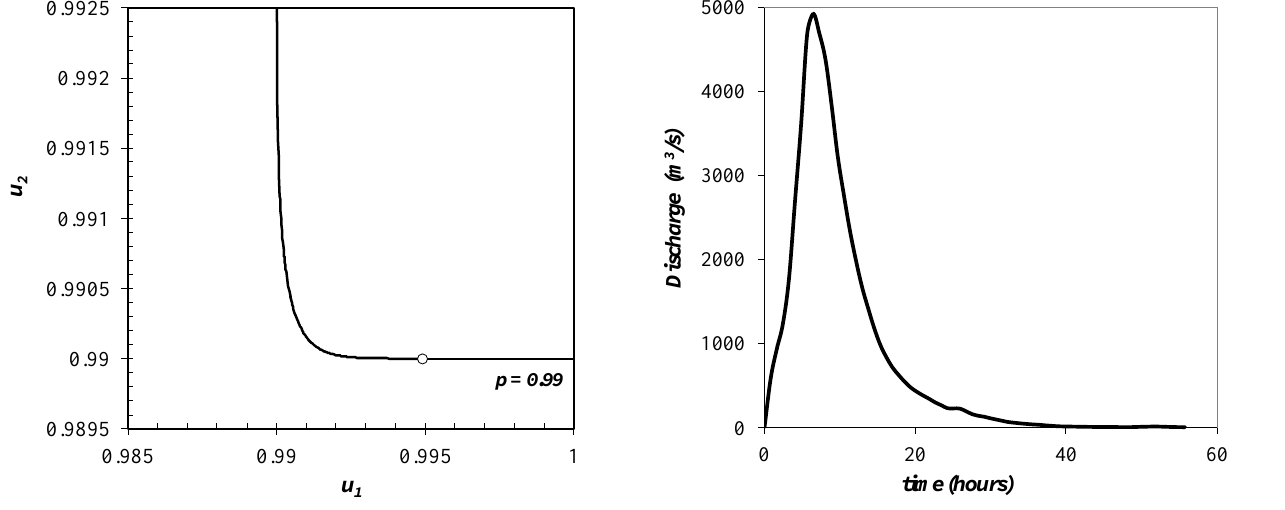
Figure 17. p level of the copula C ( u 1 , u 2 ) corresponding to a JRP = 100 years, with indication of the single design point (white dot).